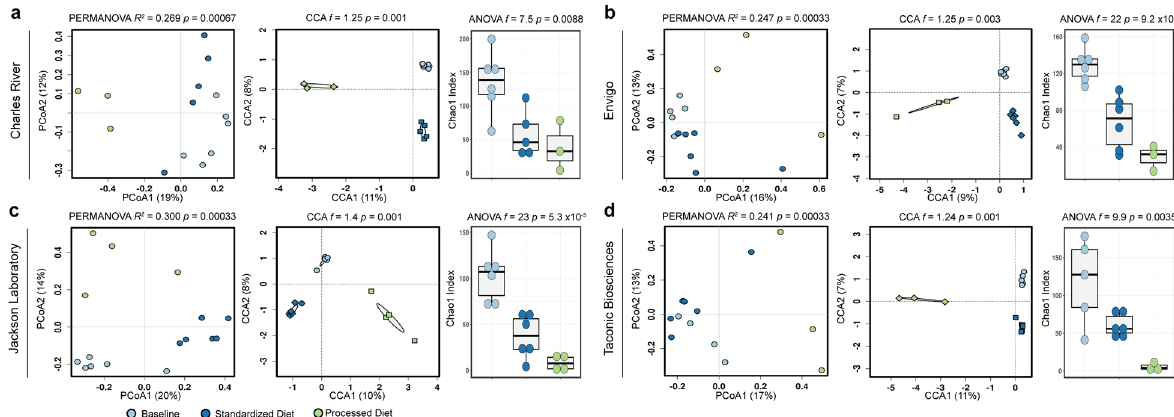
Fig. 3 Baseline fungal composition in fl uences fi nal community composition. Differences in fungal community composition and diversity present on arrival from the four laboratory mouse vendors lead to persistent differences in the composition and diversity of fungal communities ( a – d ). Hypothesis testing for community composition was performed using permutational multivariate ANOVA and canonical correspondence analysis of Hellinger transformed Bray – Curtis dissimilarity distances and community diversity by ANOVA of the Chao1 index. CCA canonical correspondence analysis, OTUs operational taxonomic units, PERMANOVA permutational multivariate ANOVA, PCoA principal coordinates analysis.